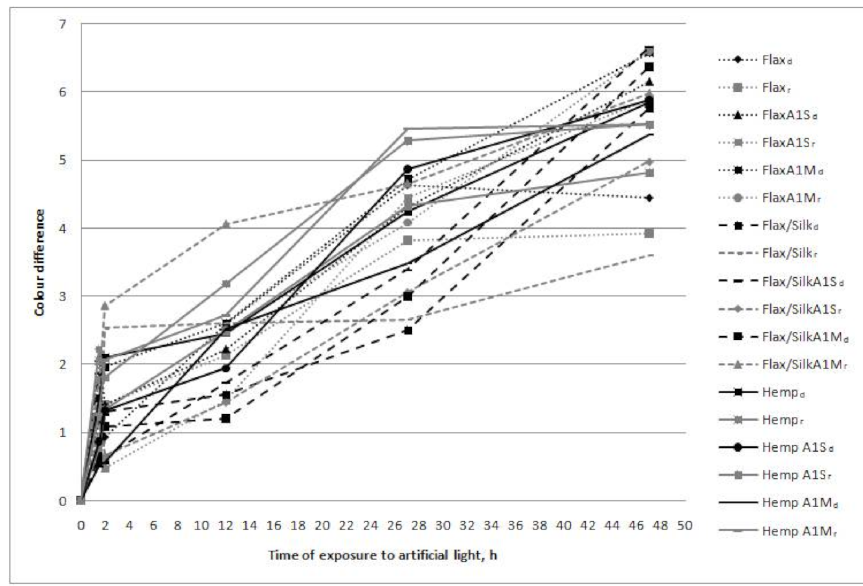
Figure 6. Relationship between ∆ E* ab and the time of exposure to artificial light for dyed unwashed and washed woven fabrics.